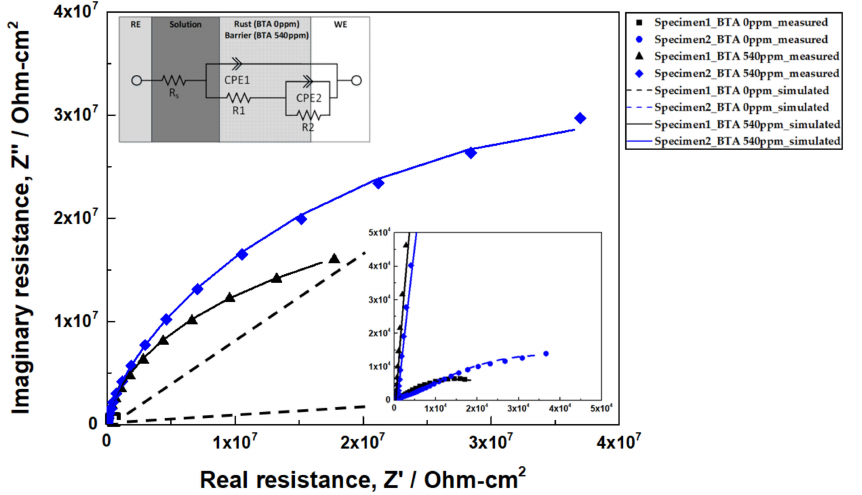
Figure 6. Nyquist plots for specimen 1 and specimen 2 and equivalent circuit for fitting in synthetic tap water at 25 ◦ C based on the presence and absence of